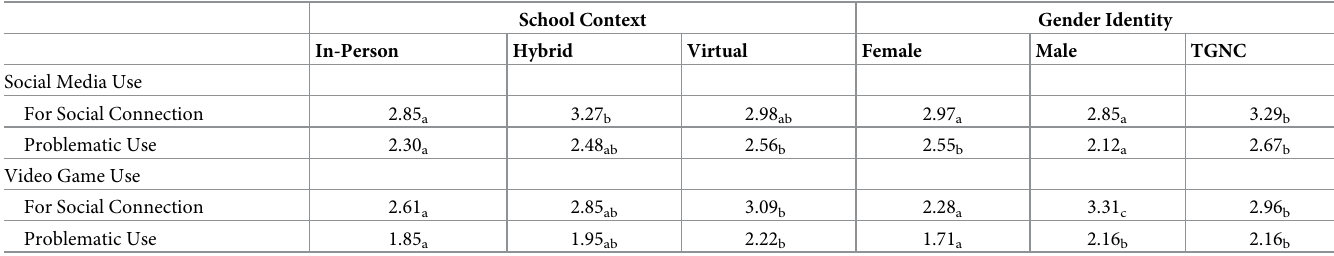
Table 4. Media use by school context and gender.